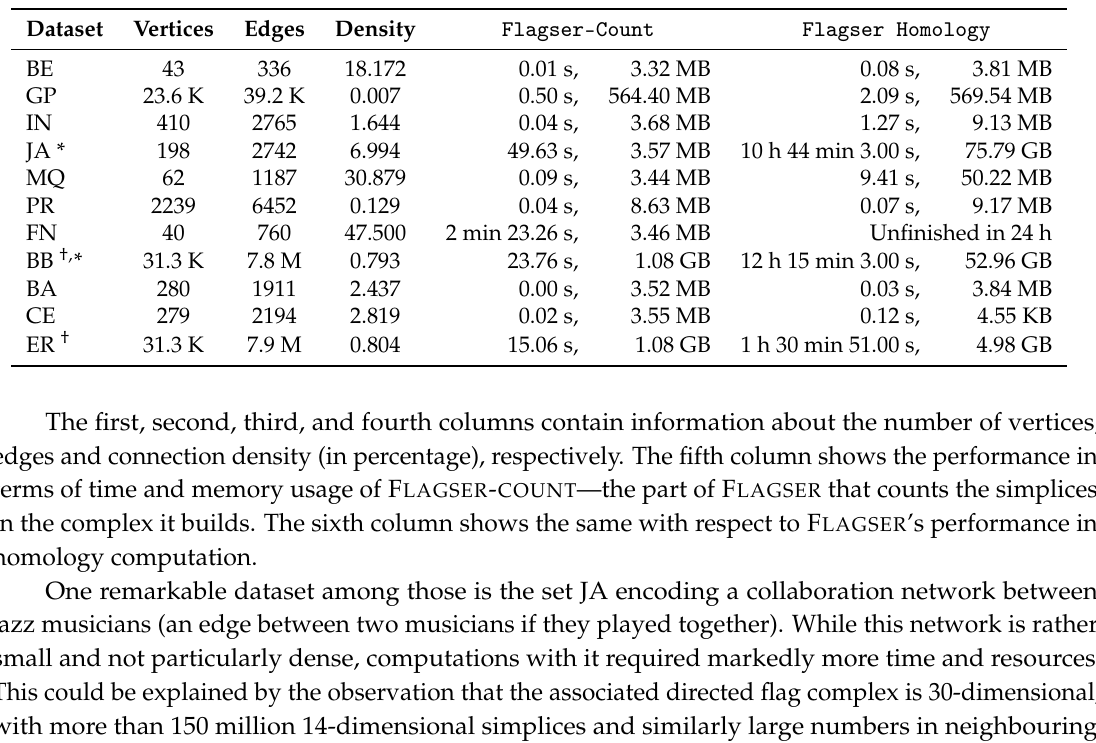
Table 1. Performance of F LAGSER on a variety of datasets: BE = Windsurfers, GP = Google+, IN = Infectious, JA = Jazz, MQ = Macaques, PR = Protein, FN = 19th step of the Rips filtration of the 40-cycle graph, BB = Blue Brain Project neocortical column, BA = Barabási–Albert graph, CE = C-Elegans, ER = Erd˝os-Rényi graph. In all cases density is given as connection probability as percentage. Dataset † means that the Approximate function of F LAGSER was used with approximation parameter 100,000.